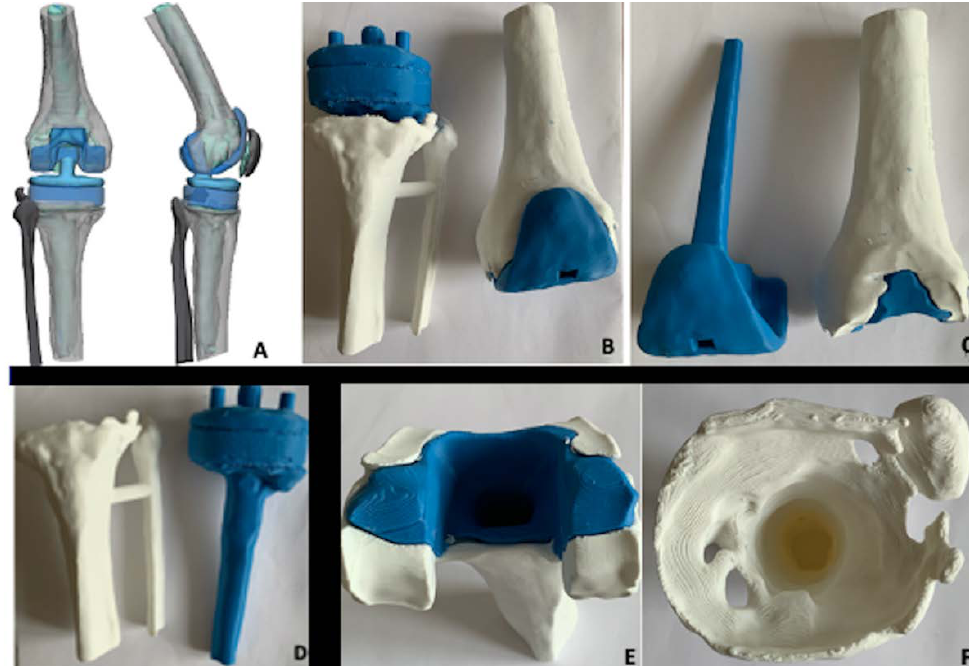
Figure 7. Three-dimensionally-printed model of the case. ( A ) Image by the company (grey bone, blue implant, light blue cement); ( B ) 3D model femoral and tibial component; ( C ) 3D femoral model with implant separated from bone-cement; ( D ) 3D tibial model with implant separated from bone without cement; ( E ) 3D femoral model showing bone (white) and cement (blue); ( F ) 3D tibial model showing tibial bone loss.